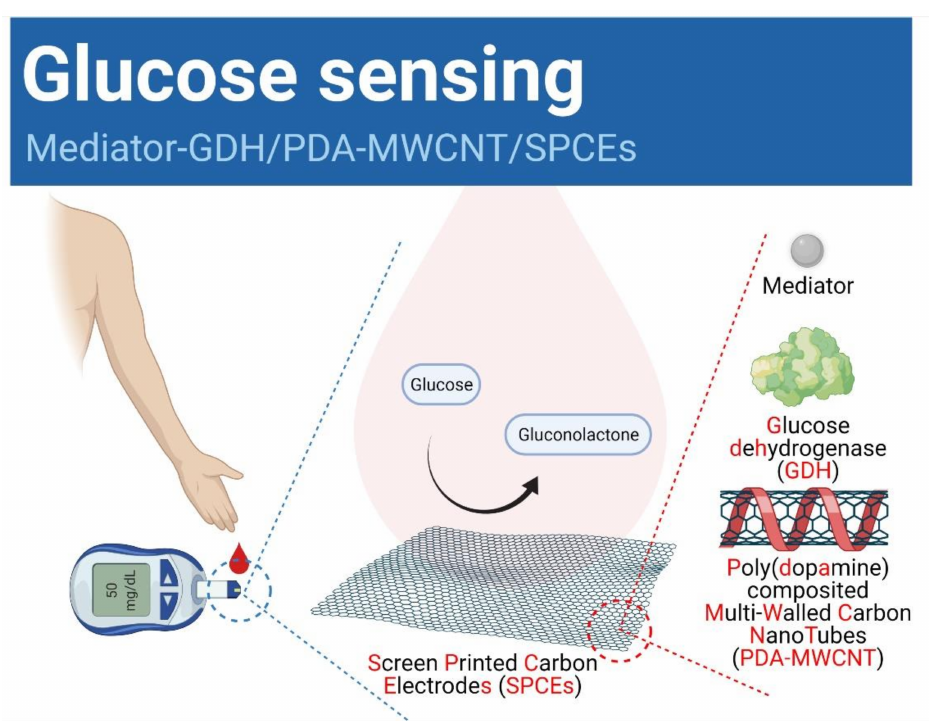
Scheme 1. Concept and composition concept of glucose sensing